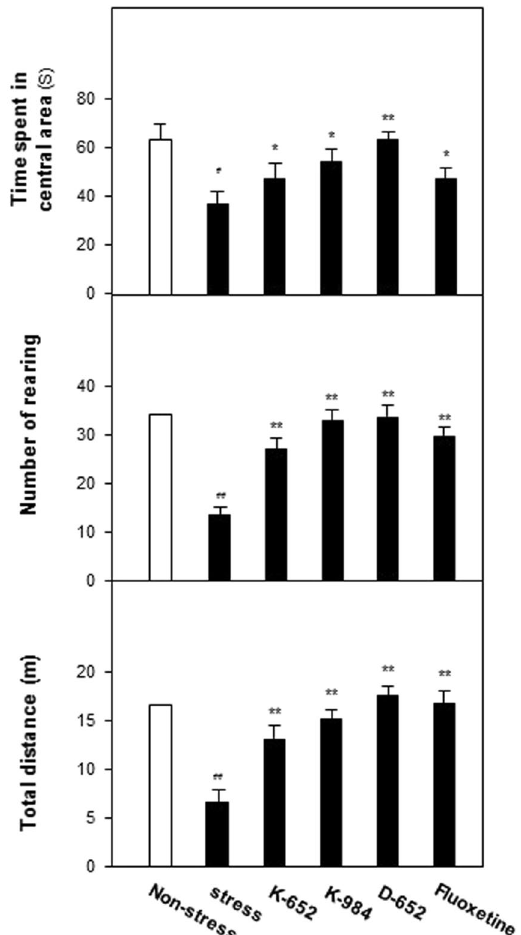
Figure 2. KXS series formulae exerted antidepressant actions in open field tests of CUMS-treated mice. After four weeks of CUMS exposure and one week of KXS series formulae treatment, all groups of mice were employed for open field tests, including time spent in central area, rearing number and total travel distance. Fluoxetine at daily dosage of 4 mg/kg was set as the positive control. KXS series formulae treatment was set for three groups, K-652, K-984, D-652, all at 10 g/kg. Values are expressed in the percentage of non-stressed group as Mean ± SEM (n = 8). Comparisons between groups were carried out by a one-way ANOVA followed by a post-hoc Bonferroni test. # p < 0.05, ## p < 0.01 (compared with non-stressed group); * p < 0.05, ** p < 0.01 (compared with stressed